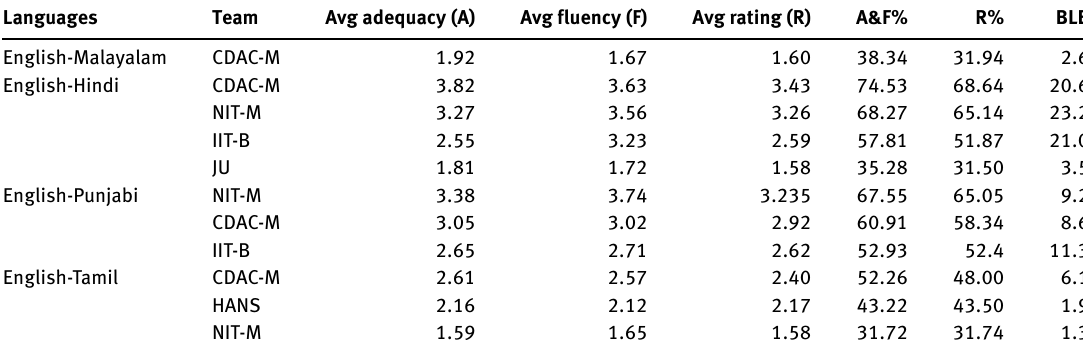
Table 7: Submissions at